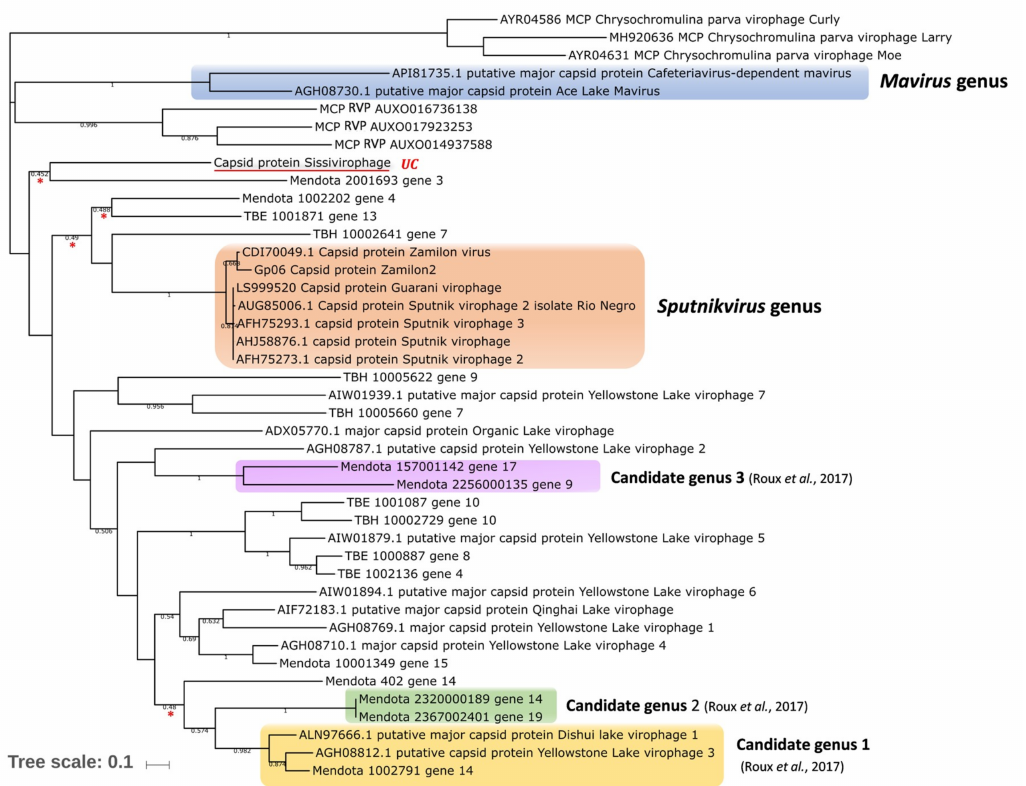
Figure 2. Phylogenetic reconstructions based on the capsid proteins of known virophages with their current / proposed taxonomy. The analysis was performed using MEGA version 7.0, applying the maximum-likelihood method and WAG ((Whelan & Goldman) model of evolution with 500 bootstrap replicates. Cuto ff ≥ 50%, branches with 45%–50% support are marked with a red asterisk. UC: Under